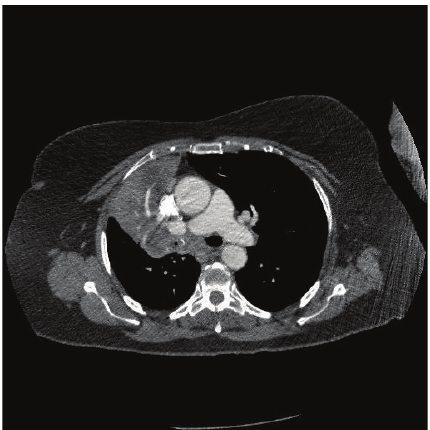
Figure 3: Bronchoscopy showing bronchial mucosal abnormalities with whitish plaques and mucosal inflammation and swelling obstructing the RUL bronchus.